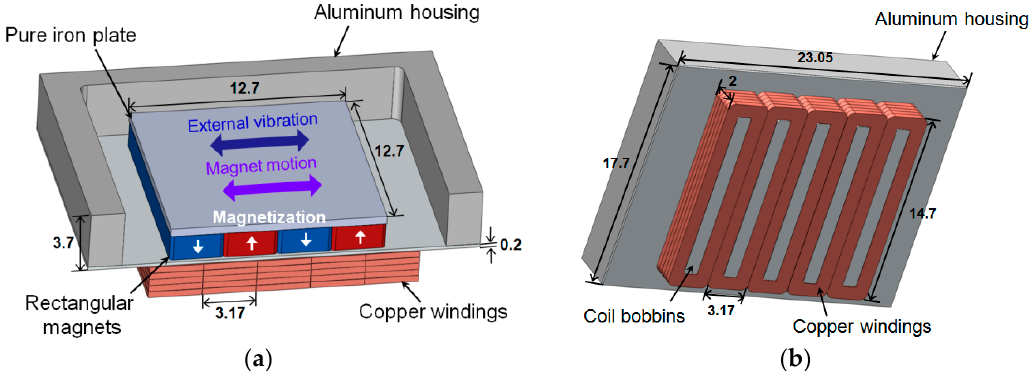
Figure 2. Schematic diagram of the proposed electromagnetic energy harvester (unit: mm): ( a ) top side; ( b ) bottom side.